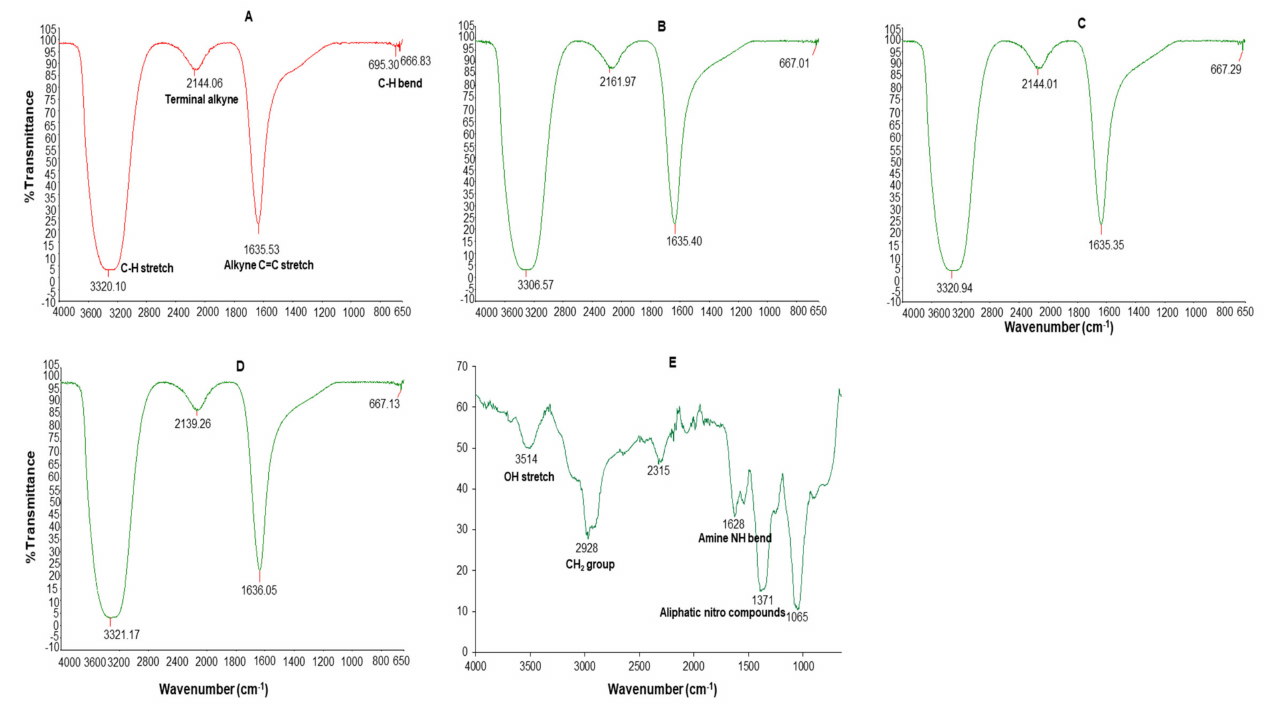
Figure 4. FT-IR spectra of C-AgNPs ( A ), GA-AgNPs_0.4g ( B ), GA-AgNPs_0.5g ( C ), GAC-AgNPs ( D ), and GAE ( E